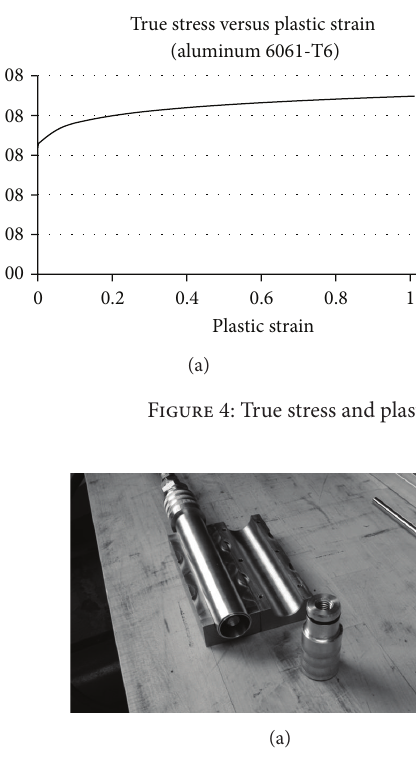
Figure 5: (a) Hydroforming test rig with annular target in place. (b) Assembled hydroforming test rig.